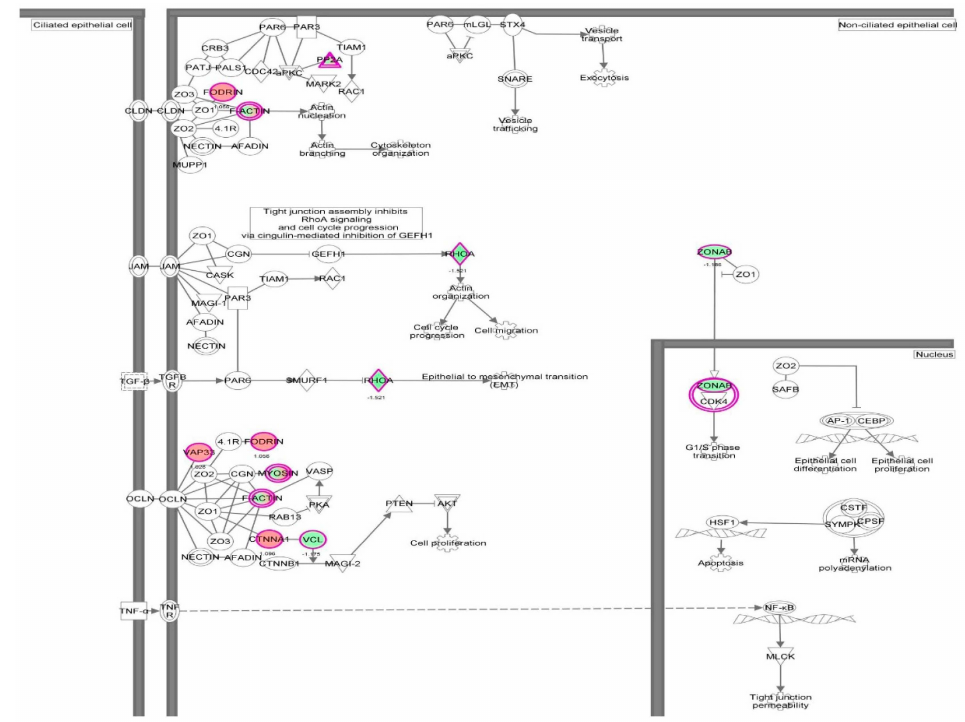
Figure 33. Tight junction signaling pathway was regulated by vancomycin in HK-2 cells. HK-2 cells were treated with 50 µ g/mL vancomycin for 24 h and the protein samples were subject to quantitative proteomic analysis. Red indicates an up-regulation; green indicates a down-regulation. The intensity of green and red colors indicates the degree of down- or up-regulation. Solid arrow indicates direct interaction and dashed arrow indicates indirect interaction.